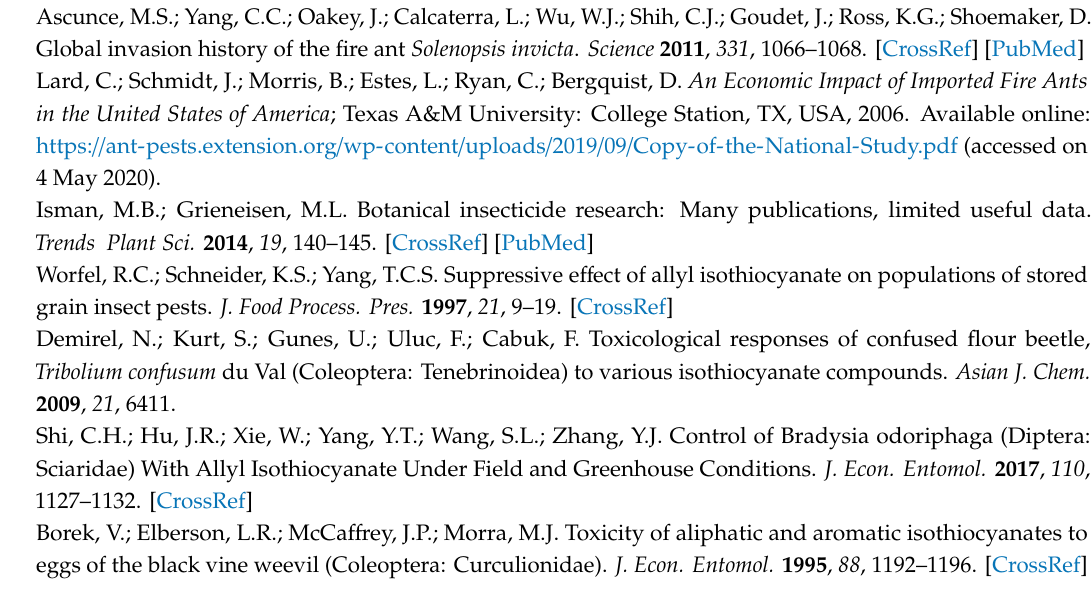
Figure S1: Total ion chromatograms of female and male Bagrada bugs in SPME-GC-MS analysis. Figure S2: Mass spectra of four isothiocyanates found in Bagrada bugs. Figure S3: The social form of fire ant, S.invicta used in this